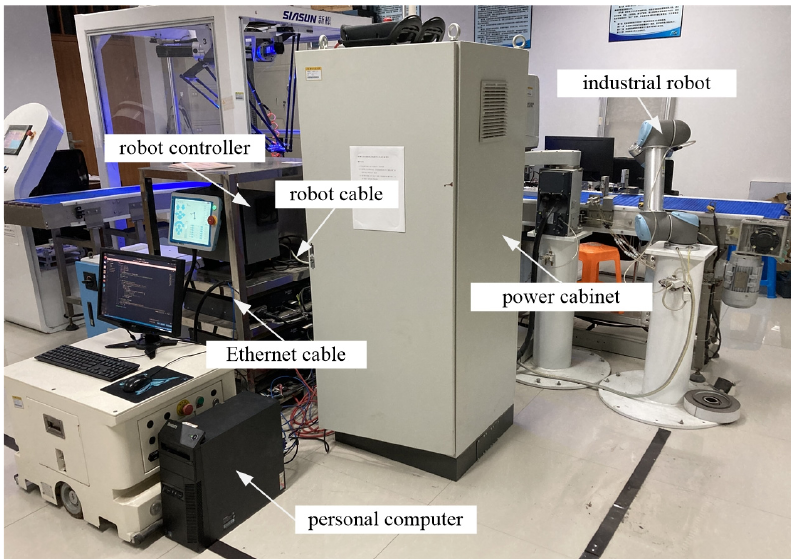
Figure 5. Experimental platform.